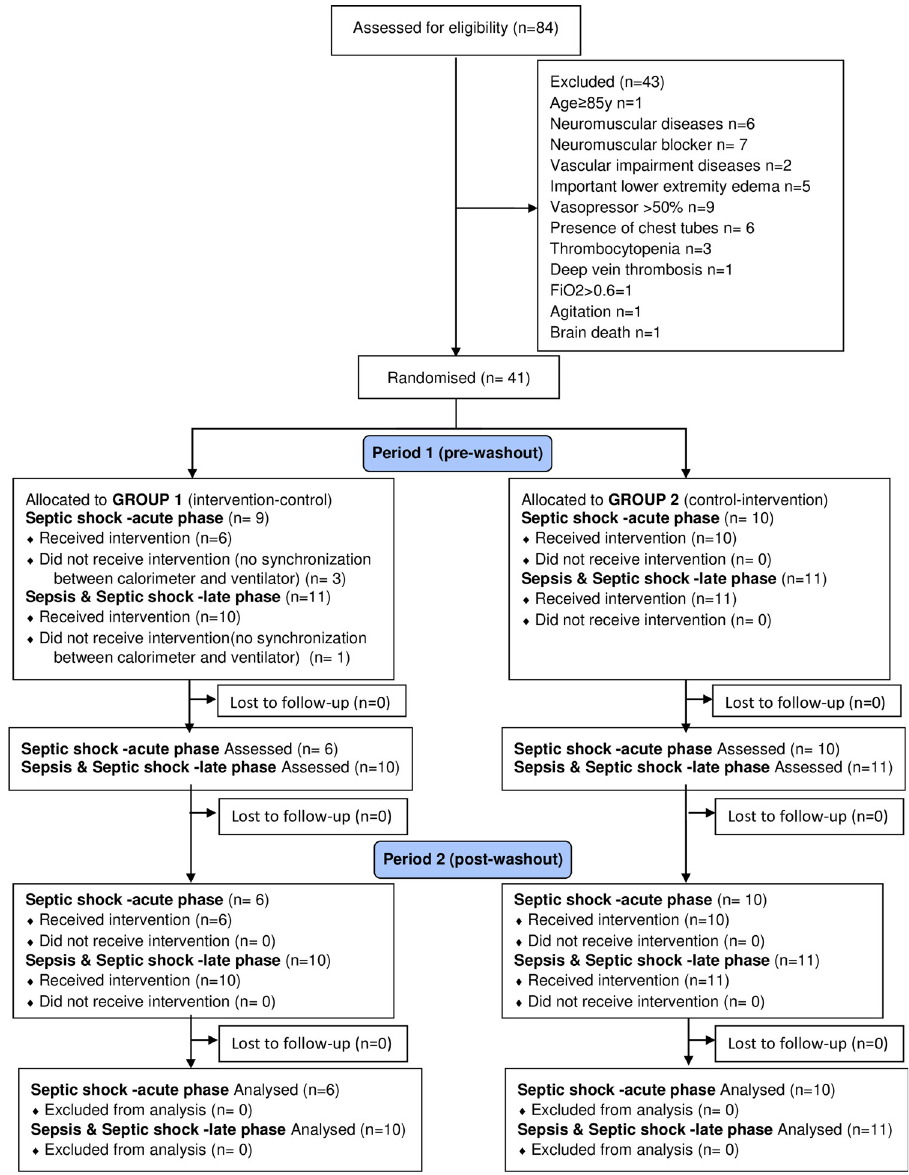
Fig 1. Participant flow. Group 1 (intervention—control) or group 2 (control—intervention) with a wash-out period of 4 to 6 hours. dioxide production, and respiratory quotient (i.e., among resting, intervention, and control protocols). Otherwise, respiratory quotient values in septic shock patients ( < 72h) showed sta- tistical differences, but without clinical relevance when comparing the resting to intervention protocols (0.70 ± 0.05; 0.68 ± 0.05, p < 0.005). When intergroup comparison was made (i.e., comparing patients in septic shock < 72h with those in sepsis and septic shock > 72 hours), oxygen consumption and energy expendi- ture showed significantly higher values and, in all protocols (baseline, intervention and con- trol), patients diagnosed in the acute phase were observed. Lower RQ values were observed in septic shock patients in the acute phase (Table 1).